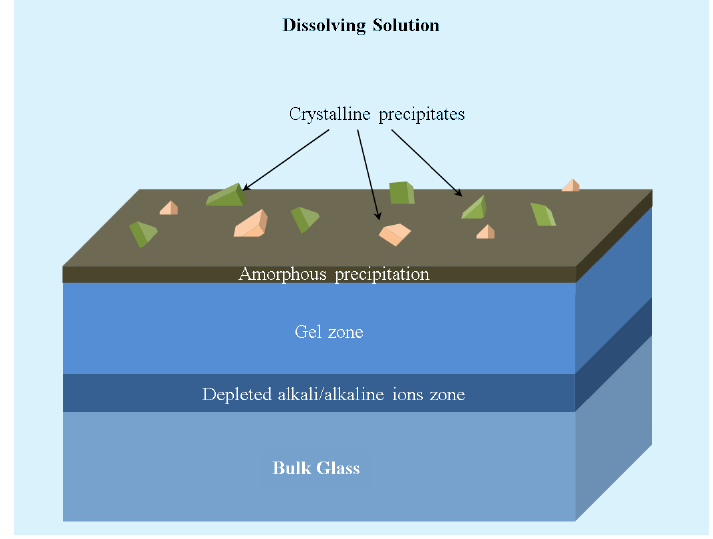
Figure 4. Schematic representation of the different zones.